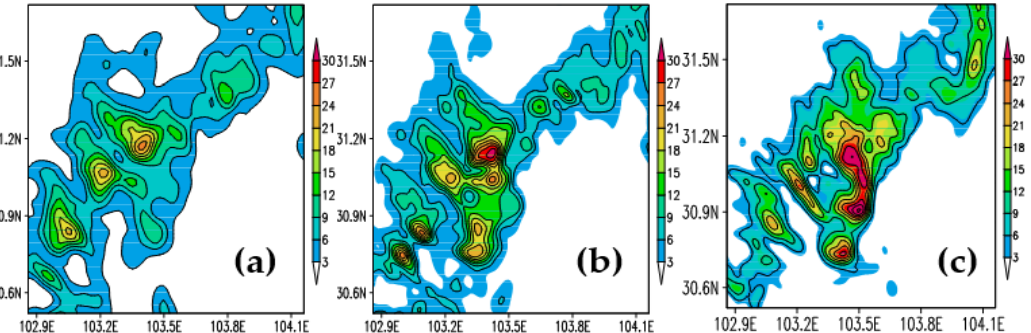
Figure 7. The 1-h accumulated precipitation (shaded, unit: mm) at 1800 UTC 9 July, 2013; ( a ) observed precipitation; ( b ) simulated precipitation under R2 with 1.9-km grid size; ( c ) simulated precipitation under R1 with 2.5-km grid size.